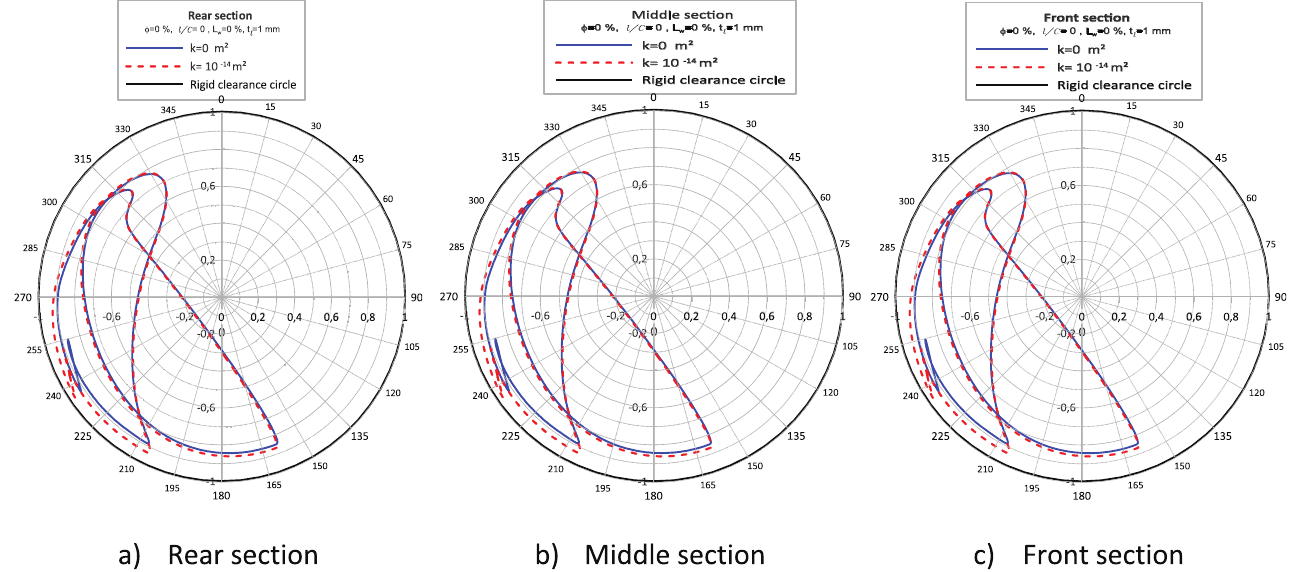
Fig. 23. Effects of bearing-liner permeability parameter on the stationary Journal axis orbits.